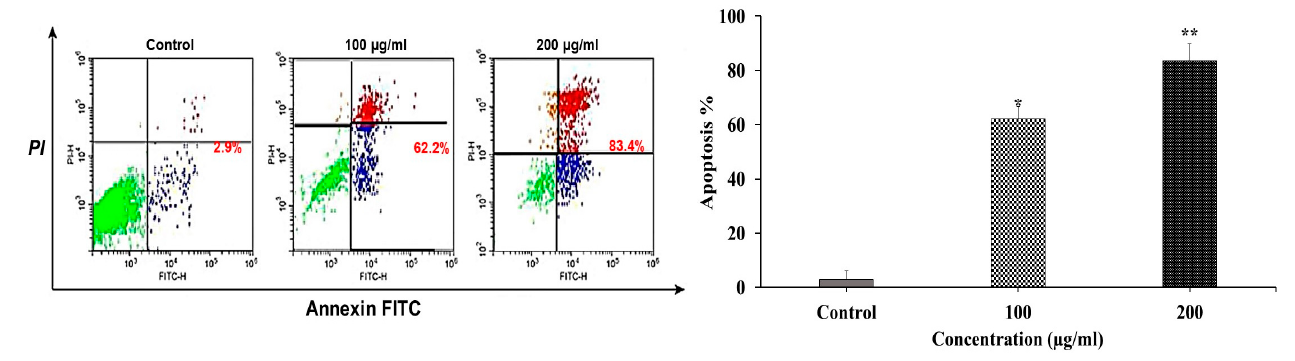
Figure 5. Induction of apoptosis by mangiferin in MCF-7 cell line, as shown by the annexin V-FITC and PI apoptosis analysis. Cells were treated with 100 and 200 µ g/mL of mangiferin for 48 h. The results are presented as mean ± SD (n = 3). The data were analyzed utilizing a one-way ANOVA, followed by Dunnett’s post hoc test. Statistics were considered significant at p < 0.05. * p < 0.05 and ** p < 0.01 compared with the